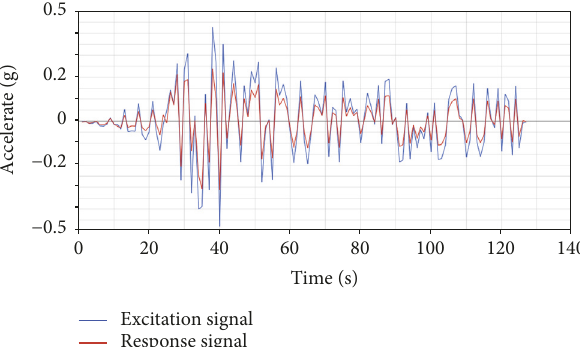
Figure 4: Excitation/response signal collected by frequency sweep experiment. The abscissa is for the sweep time (s), and the vertical axis is for the excitation amplitude